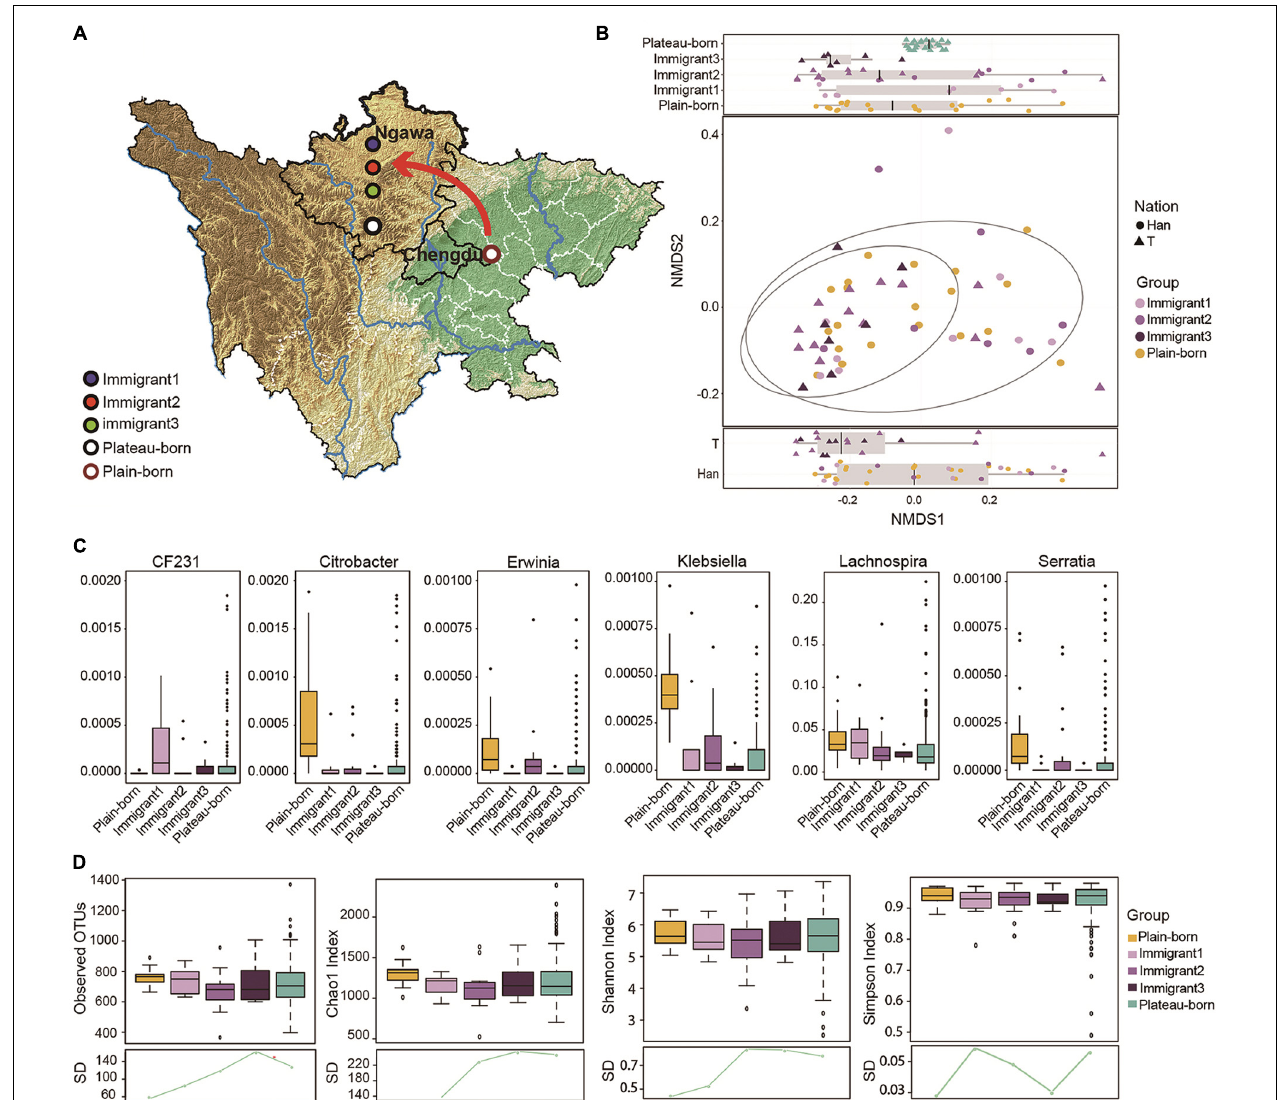
FIGURE 3 | The reverting immigration from the basin to the plateau also promotes microbiome succession. (A) Immigrant 1 (born in the plains and moved to the plateau), Immigrant 2 (born in plateau and whose parents born in plain), Immigrant 3 (born in plateau and whose grandparents born in plain), plateau-born (born and living in plateau), plains-born (born and living in plain) and plateau- Trans (born in the basin or the ancestors were born in the basin and moved to the plateau) are marked on the graphics. (B) NMDS analysis based on the genera profile from plateau-born ( n = 586), plain-born ( n = 20), and plain to plateau ( n = 36) individuals, difference between nations was shown at the bottom ( P = 0.009822) and difference between immigrate generations was displayed at the top ( P = 0.04825), P -values are from Kruskal–Wallis test, and the NMDS1 values for Plateau-born individuals were the averages of 50 samples at random sampling (20 times). (C) Relative abundance of genera significantly correlated with immigrate generation (Spearman’s correlation, adjusted P < 0.05). (D) Alpha diversity between plateau-born, plain-born, and 36 plain to plateau individuals, the standard deviation (SD) in different groups revealed convergence variant from plateau to plain, * P < 0.05. The red arrows indicates the direction of